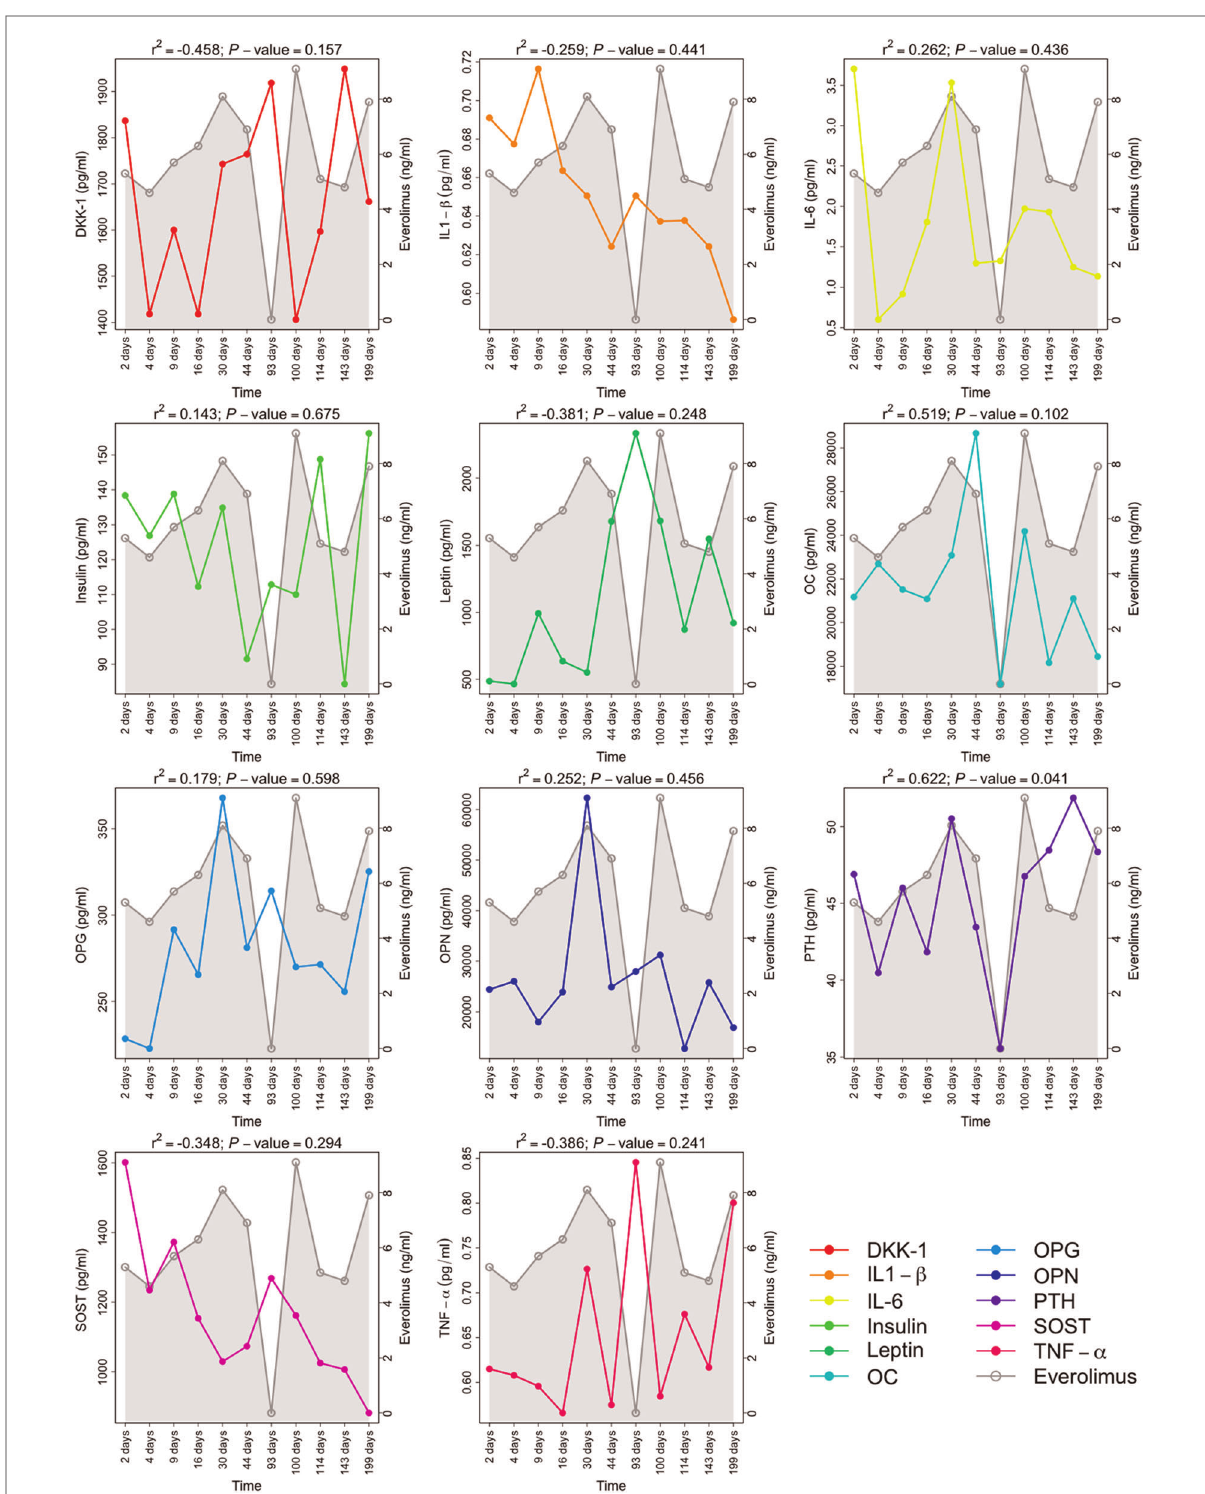
FIGURE 3 Follow-up of the cytokines as bone metabolism-related biomarkers during immunosuppressive treatment with Everolimus. All the biomarkers levels presented are expressed in pg/ml, and Everolimus serum levels are measured in ng/ml. Pearson ’ s correlation coef fi cient between the corresponding bone metabolism-related markers and Everolimus levels are displayed with the P -values. The bone metabolism-related markers presented are DKK-1, Dickkopf-related protein 1; IL1- β , interleukin 1 beta); L-6, interleukin 6; OC, osteocalcine; OPG, osteoprotegerin; OPN, osteopontin; PTH, parathyroid hormone; SOST, sclerostin; and TNF- α , tumor necrosis